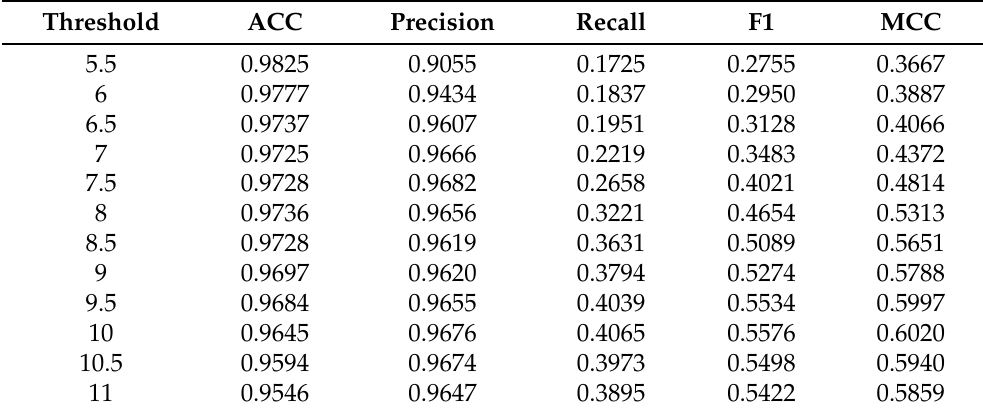
Table 6. The ability of TMP-SurResD to predict residue contacts by setting different thresholds of predicted values 1 .